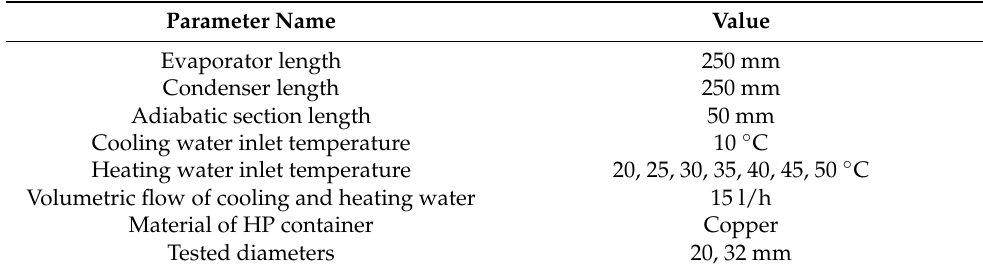
Table 1. Parameters of the experiment [24].